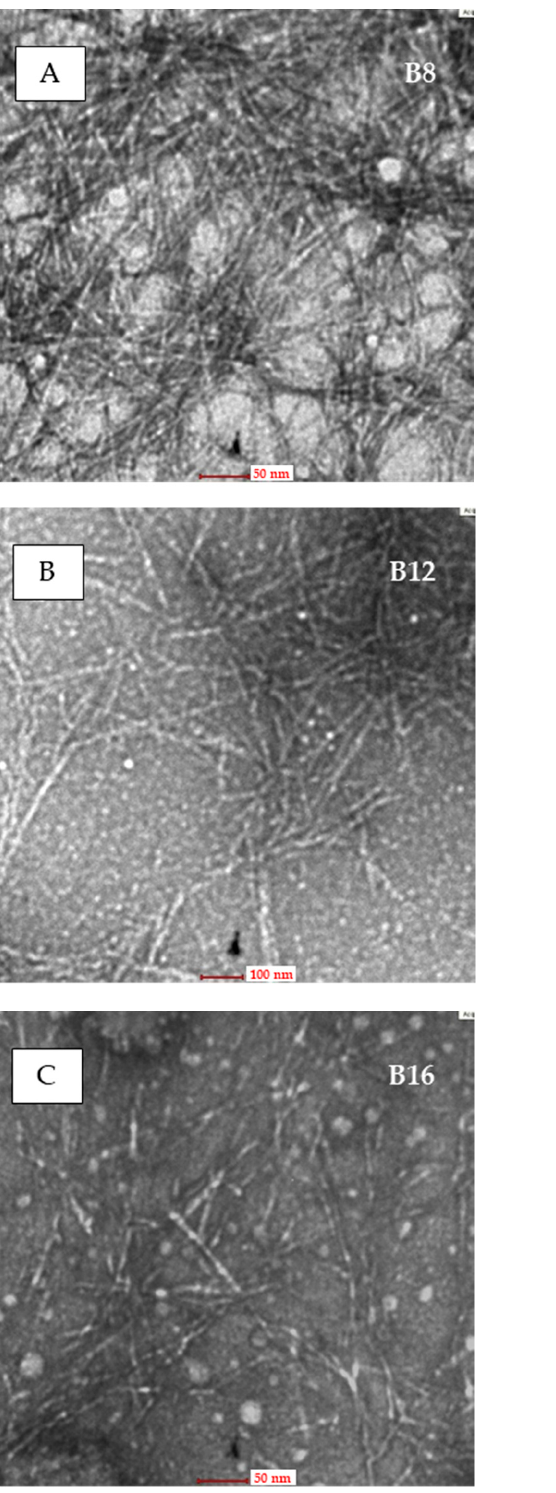
Figure 3. Transmission electron microscopy images of the rod-like CNCs obtained by APS oxidation of balsa fiber ( left ) and kapok fiber ( right ) for different oxidation times: ( A ) 8 h, ( B ) 12 h, and ( C ) 16 h. Table 1. Balsa and kapok fiber CNC size distributions.